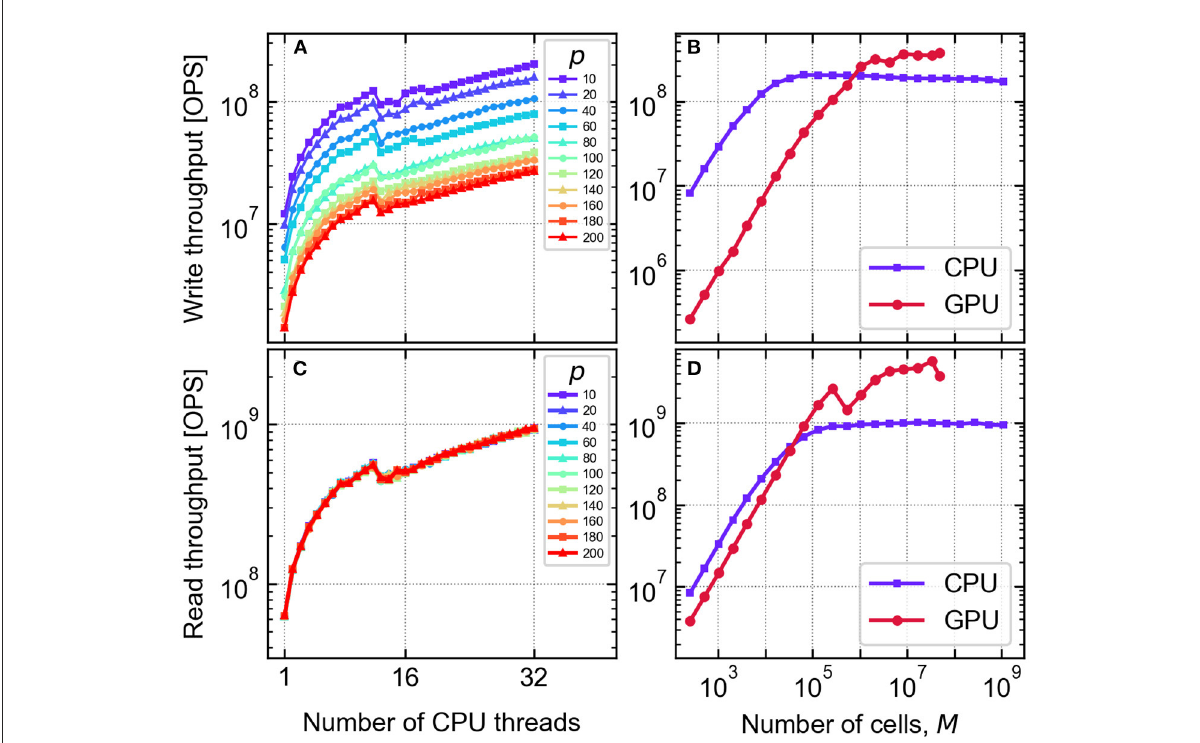
FIGURE15 Benchmarks of the read/write operation throughput per cell of the Julia model implementations. In (A,C) , an array of 2 20 ( simulated on the CPU as a function of number of parallel threads spawned, and the VAR model order p . In (B,D) , the CPU (32 threads) and GPU implementations are benchmarked vs. the cell array size M , with p